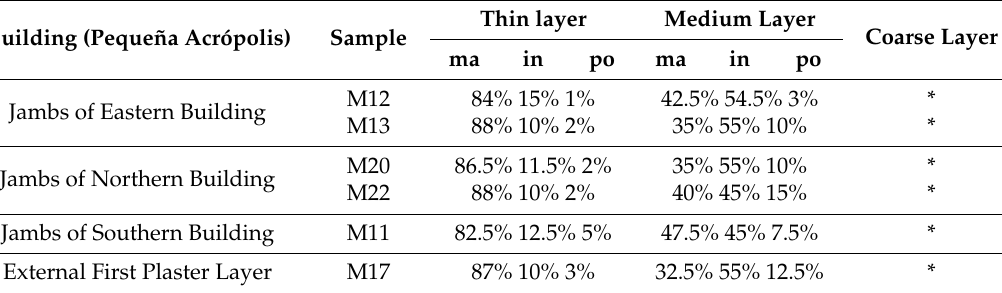
Table 7. Proportions in the Type 3 plasters; the data are based on the percentage of matrix